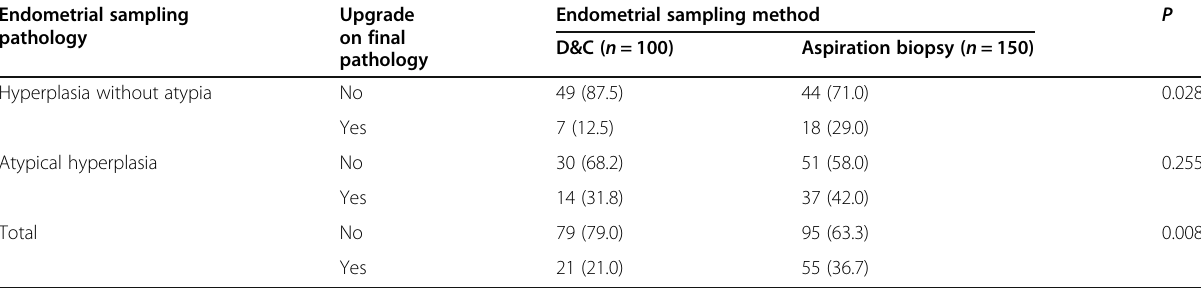
Table 4 Comparison of postoperative pathological upgrade risks based on endometrial sampling methods Endometrial sampling